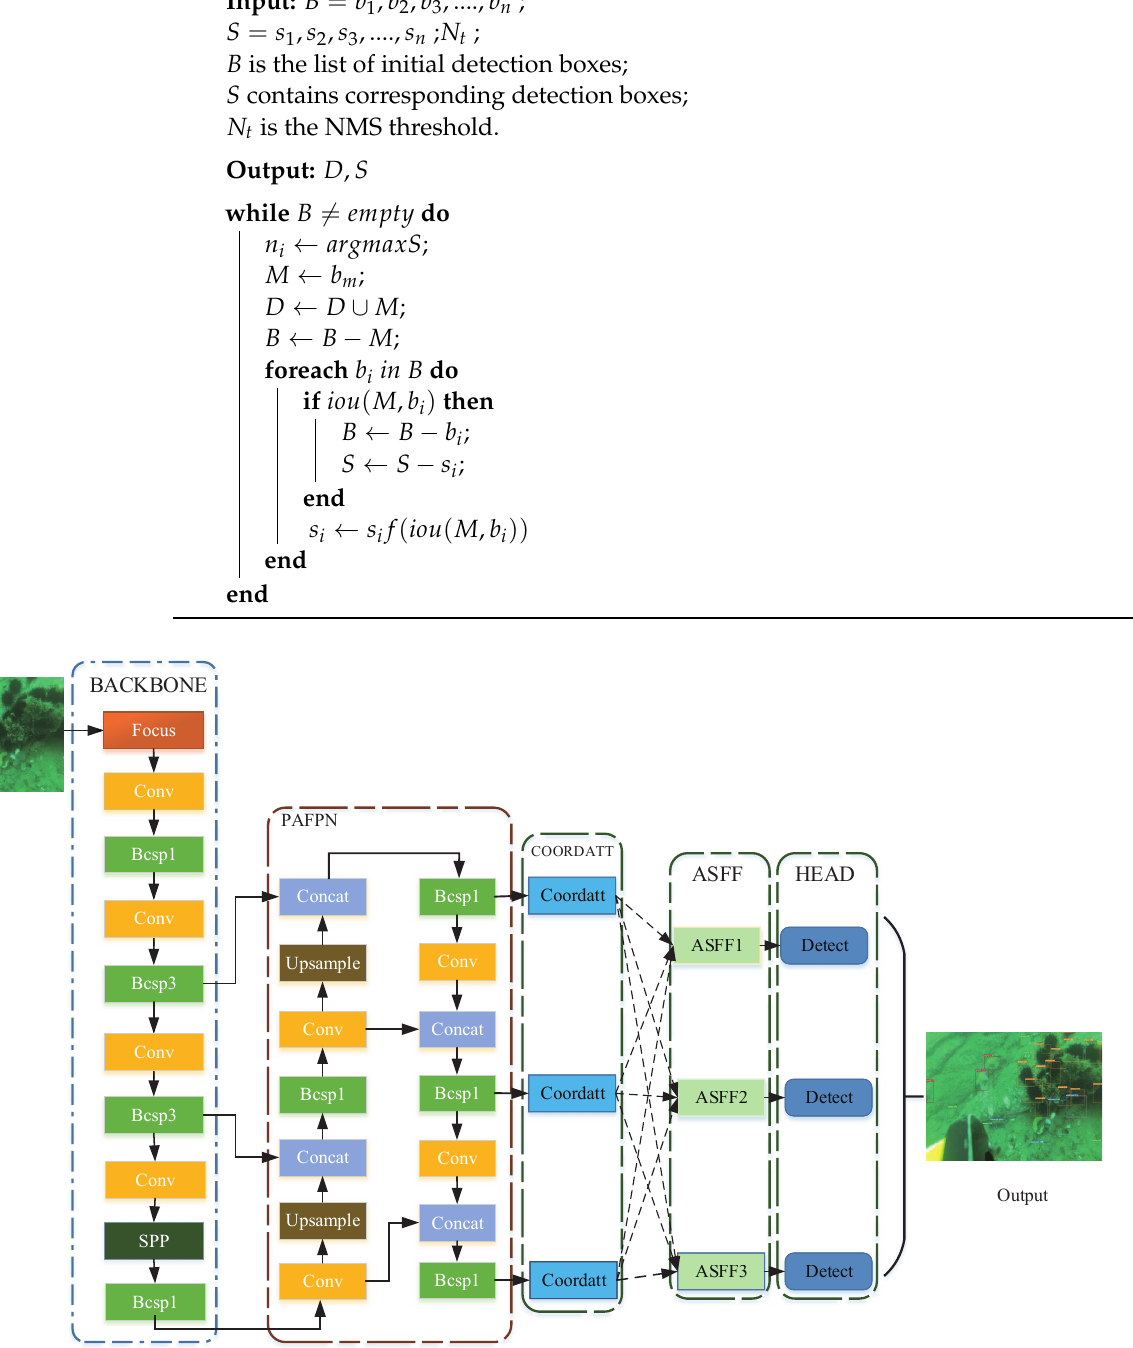
Figure 4. The Improved YOLOv5S structure diagram. Compared with the original model, it adds CA in the feature extraction section and ASFF in the detection header